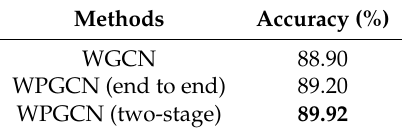
Table 2. The accuracy of WPGCN is improved by the PGCN auxiliary branch and the comparison of recognition accuracy between the two training methods. The best result is shown in